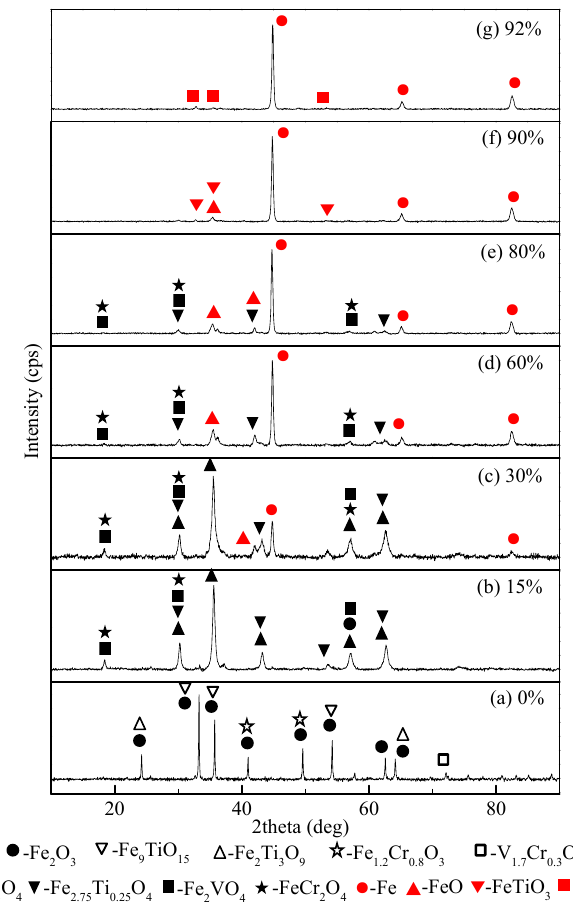
Figure 12. XRD analysis of the HCVTM pellets with different reduction ratios, ( a ) 0% ( b ) 15% ( c ) 30% ( d ) 60% ( e ) 80% ( f ) 90% ( g ) 92%. Table 3. Phase compositions of the HCVTM pellets at different reduction ratios. Reduction Ratio (%)